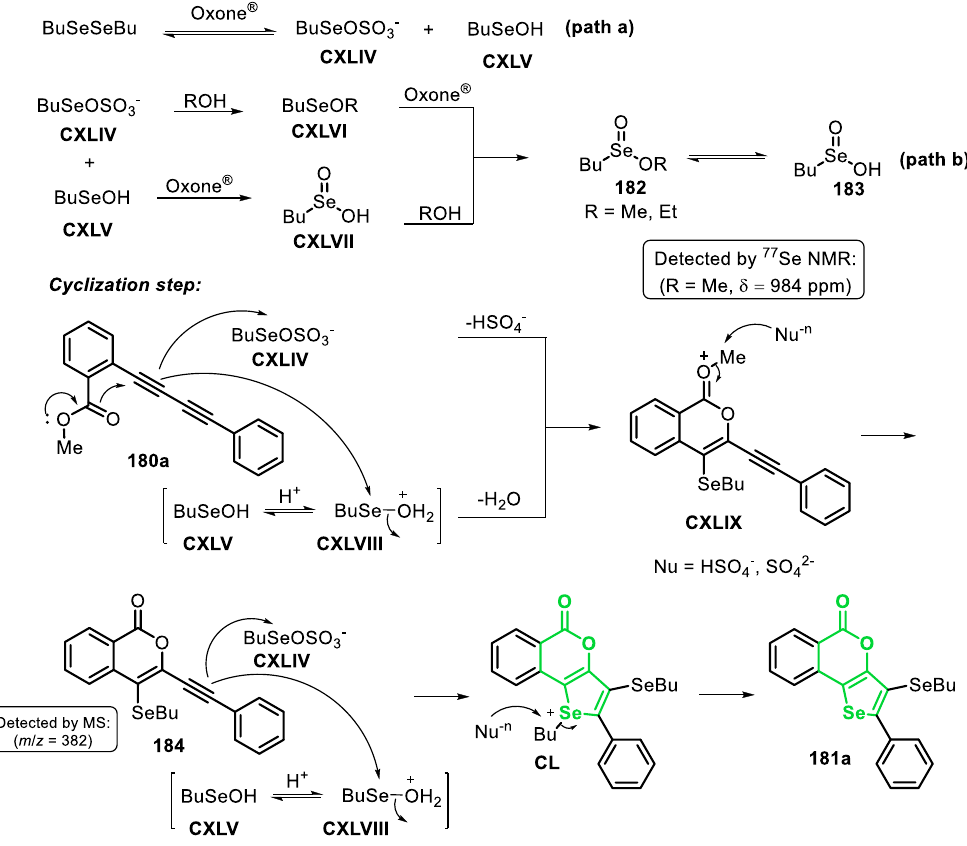
Scheme 126. Mechanism of the synthesis of isochromenones fused to selenophene 181a